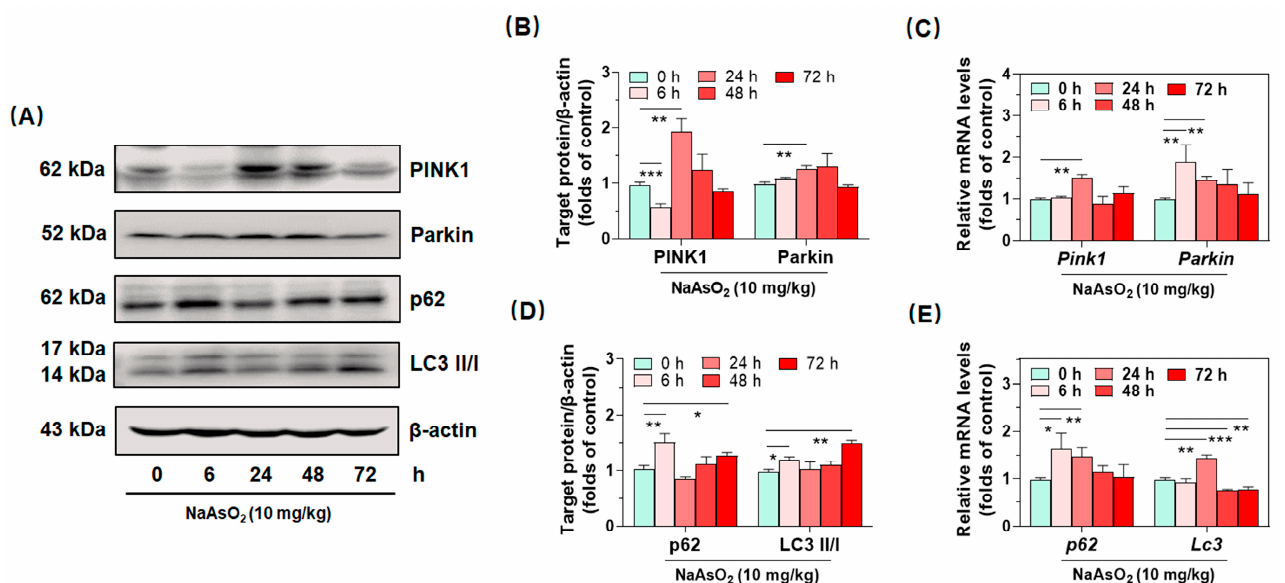
Figure 4. Activated PINK1/Parkin-mediated mitophagy in the livers of acute arsenic-exposed mice. ( A ) hepatic expression of proteins PINK1, Parkin, p62, LC3II/I were determined by Western blotting, of which protein densities are shown ( B , D ), ( C , E ) gene expression of Pink1 , Parkin , p62 and Lc3 were determined by real-time qPCR, of which relative mRNA levels normalized to Gapdh are shown, at different time points after an oral administration of NaAsO 2 . Data were presented as mean ± SD ( n = 4). * denotes p < 0.05 compared with the control group. ** denotes p < 0.01 compared with the control group. *** denotes p < 0.001 compared with the control group.